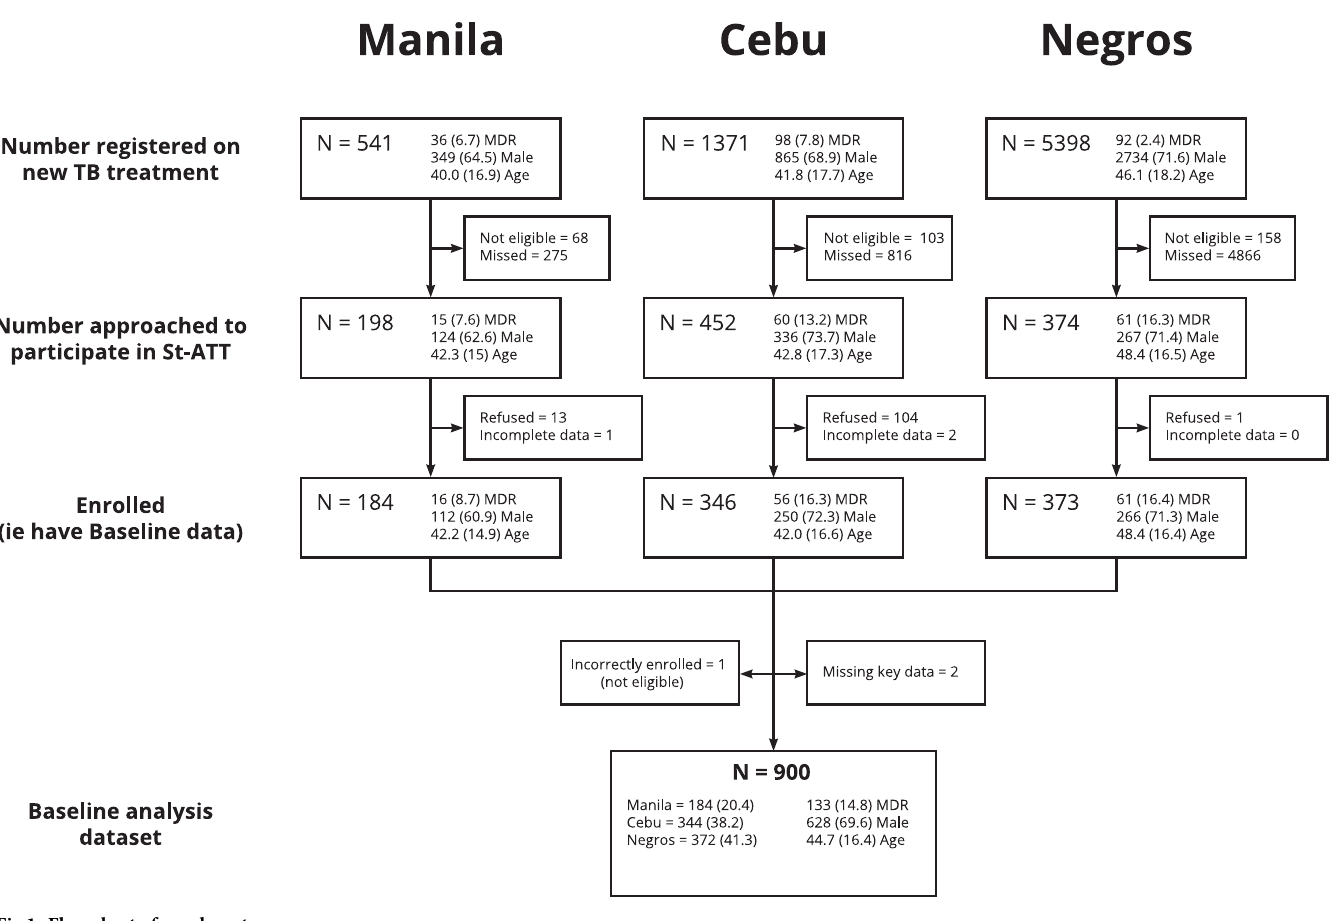
Fig 1. Flow chart of enrolment. ( Table 1 ). All but 1 of the 133 participants on MDR-TB treatment were bacteriologically con- firmed and 5.5% of New TB cases were initiated on MDR treatment, ranging from 6.9% in Cebu to 2.5% in Metro Manila ( S3 Table in S1 File ).